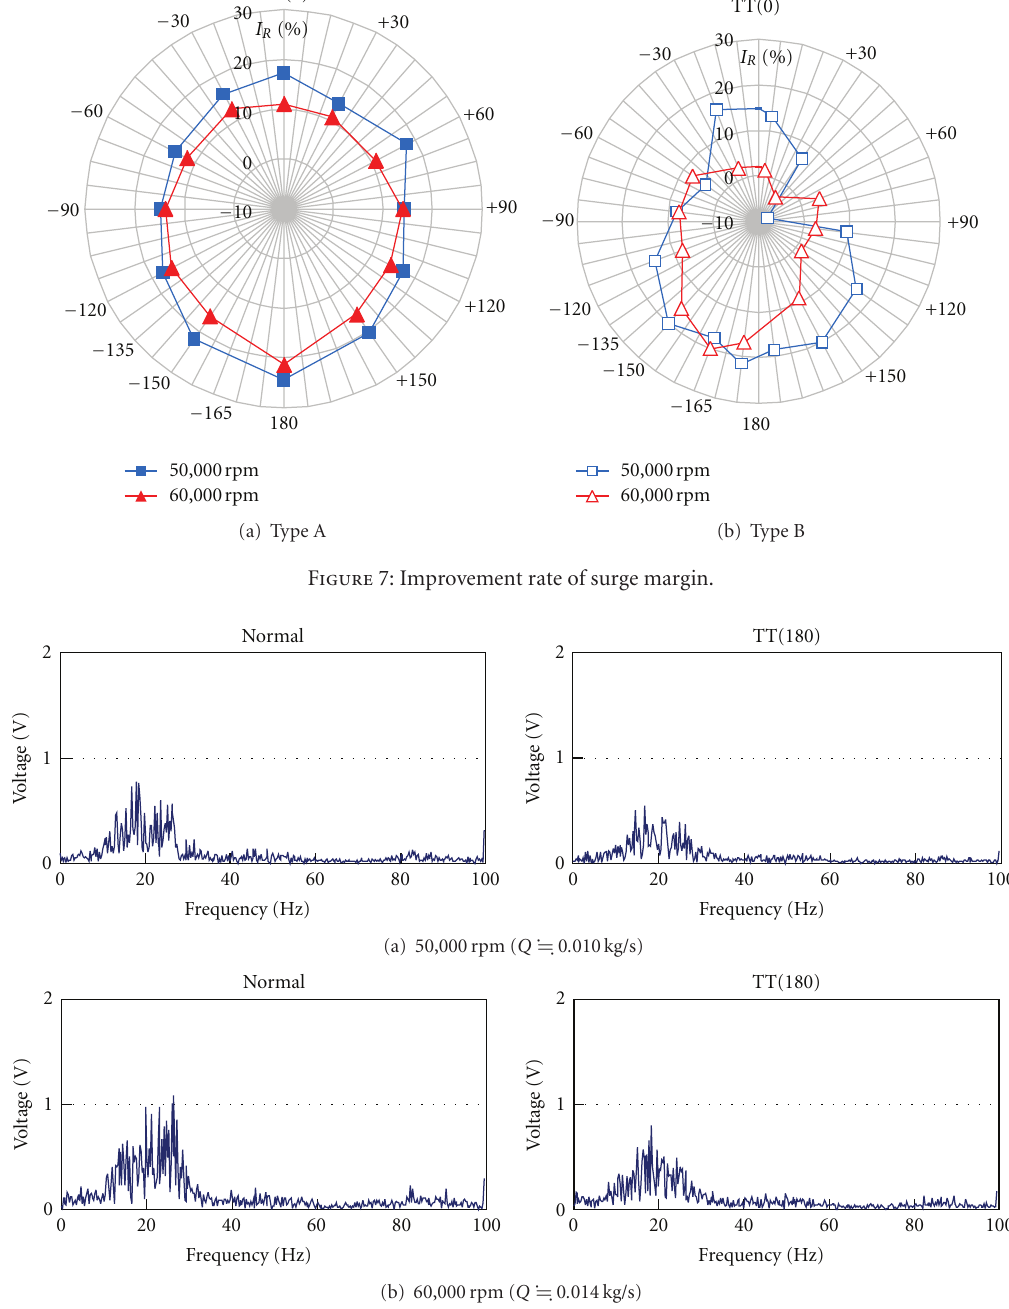
Figure 8: Spectrum of pressure fluctuation at delivery